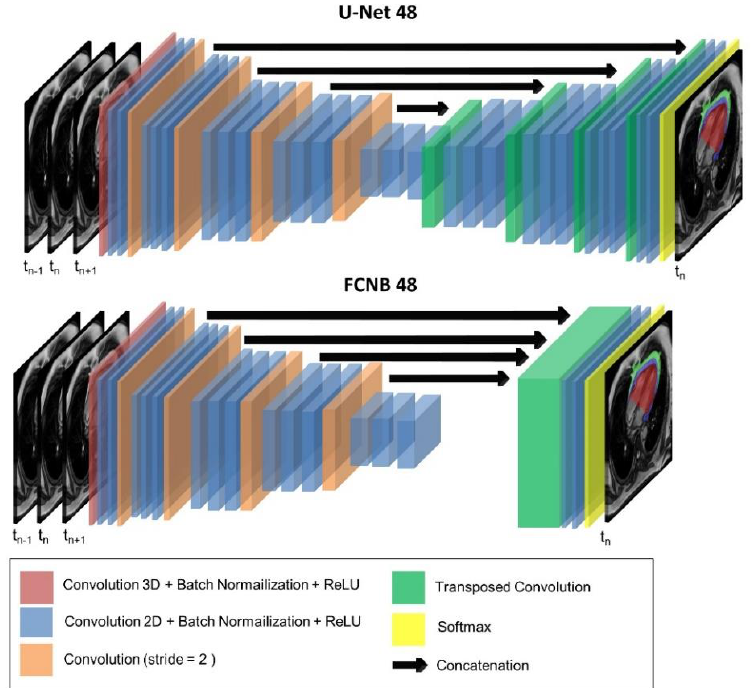
Figure 2. Networks’ optimized architecture. The two networks evaluated in this study: U-Net and fully-convolutional network (FCNB) architectures included a first 3D convolution layer to allow multiple cardiac frames as input. Following 2D convolution layers encoded images from 48 features up to 768 features. Eventually, the decoder targeted three labels for segmentation in the central input frame: epicardial adipose tissue (EAT), paracardial adipose tissue (PAT), and heart ventricles (HV).